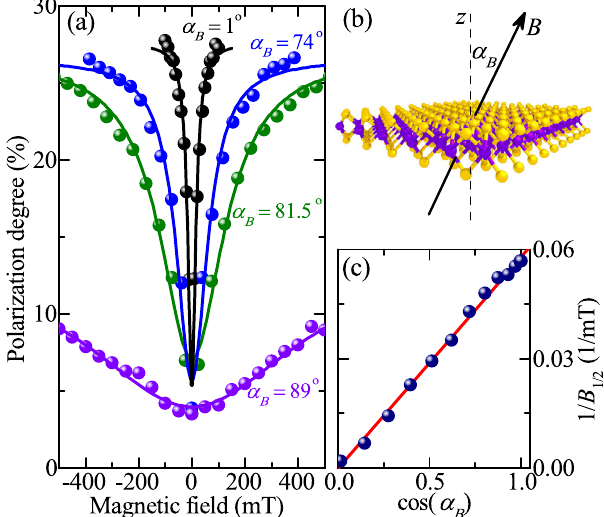
FIG. 2. (a) The circular polarization degree of the WSe 2 monolayer PL measured vs the magnetic field in the energy range between E ¼ 1650 meV and E ¼ 1715 meV, which corresponds to the emission band of the localized excitons. Each set of data points corresponds to a different orientation of the magnetic field, which is quantified by the angle α between the B field vector and the out-of-plane direction z [as schematically depicted in (b)]. The angles α were determined with an accuracy B of less than 2°. (c) The inverse width 1 =B 1 of the magnetic- = 2 field-induced dip in the circular polarization degree as a function Þ . The solid line represents the linear of cos ð α B